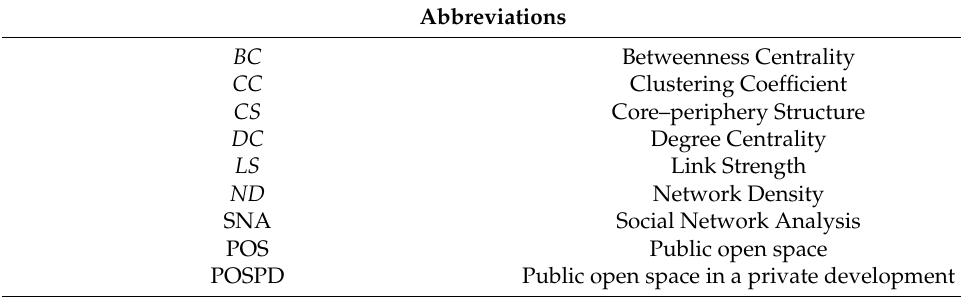
Table A1. Abbreviations of relevant terms in the